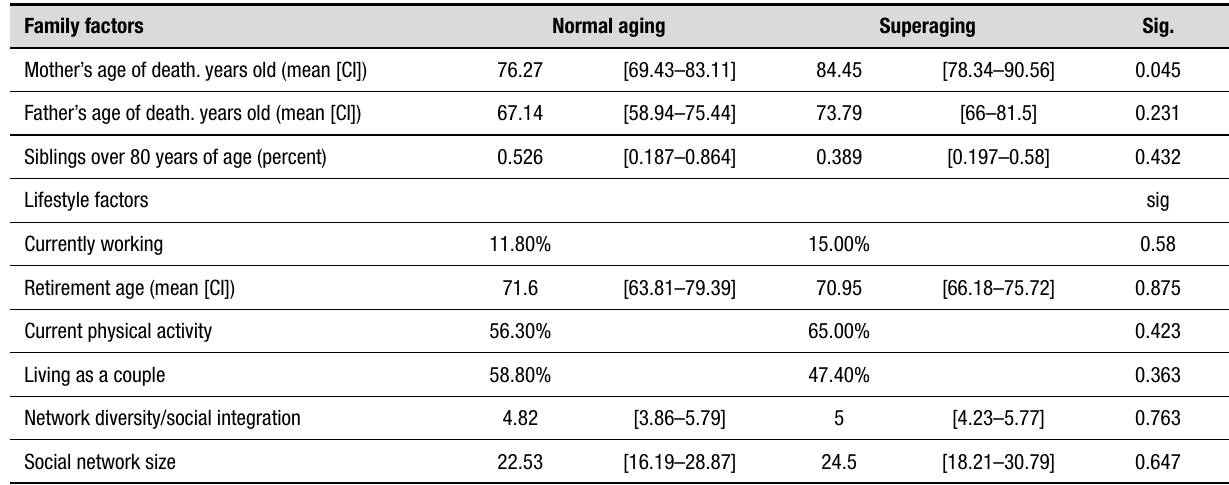
Table 2. Family and lifestyle factors. Family factors Normal aging